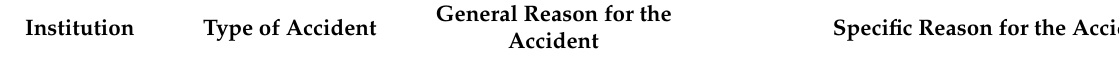
Table 4. Characteristics of students’ accidents at Johannes Gutenberg University